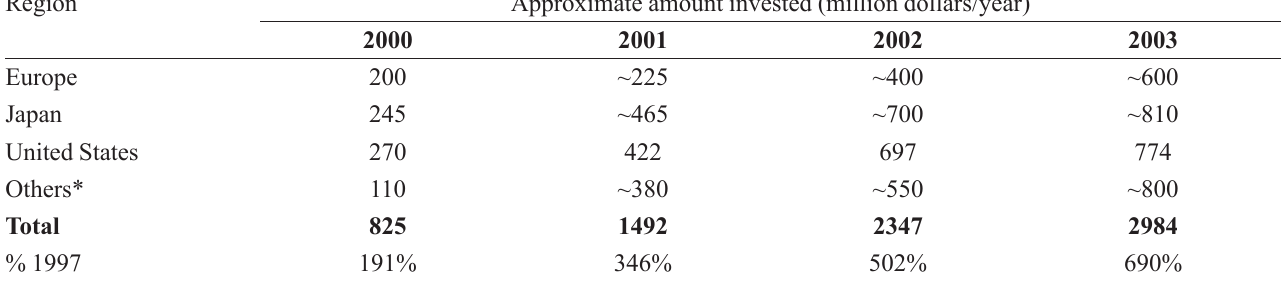
TABLE I – R&D governmental investments in nanotechnology, 2000-2003 Region